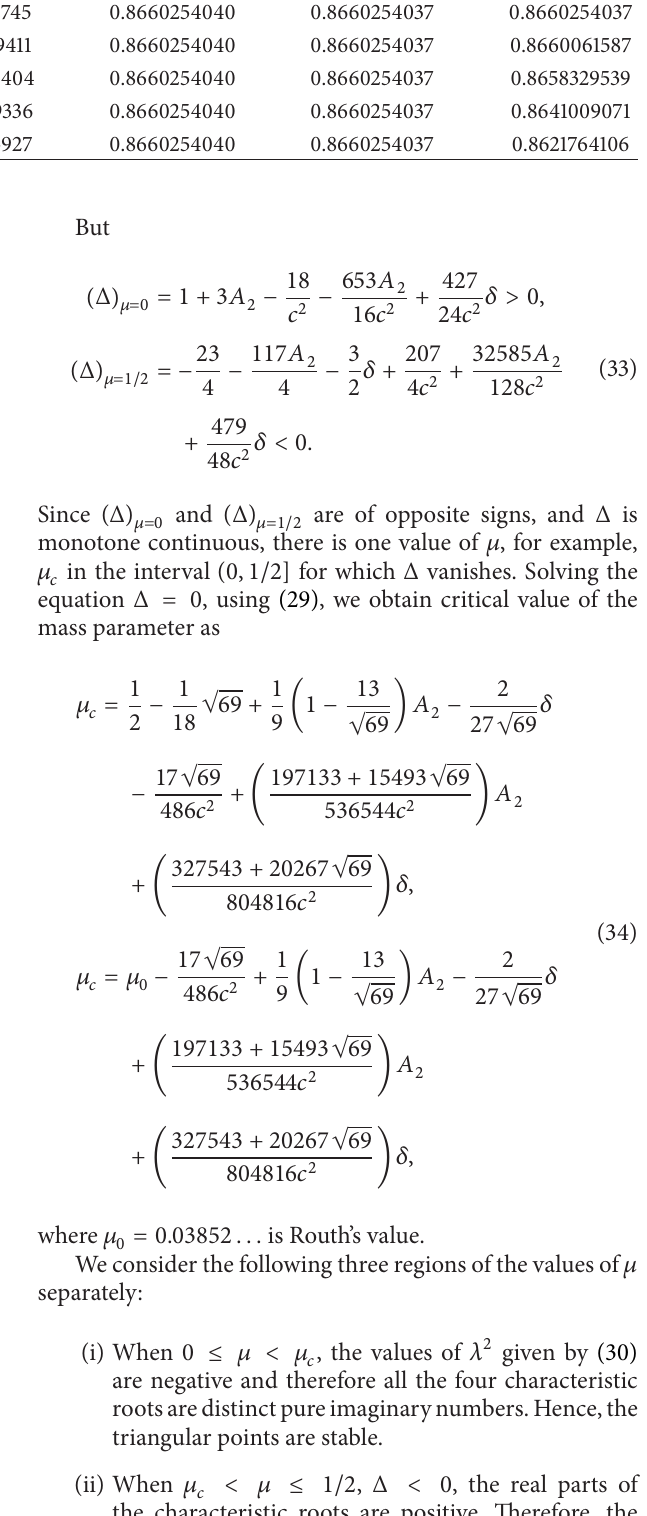
Table 5: Locations of triangular points. Sun-Saturn system: 𝑐 = 31050.90 , 𝜇 = 0.000285726000 , and 𝐴 2 = 0.0000018690 × 10 −8 . 𝜉 ±𝜂 𝛿 Classical Relativistic Equation (14) Classical Relativistic Equation (14) 0.0